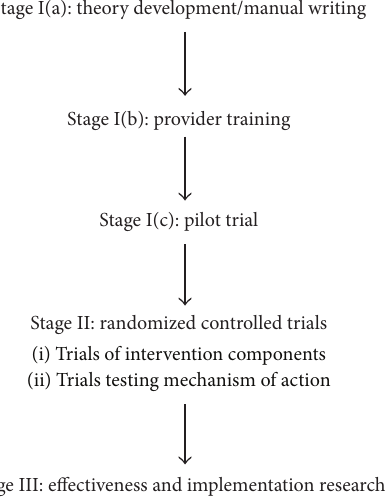
Figure 4: Adapted Rounsaville model of behavioral intervention development. Note . Adapted from